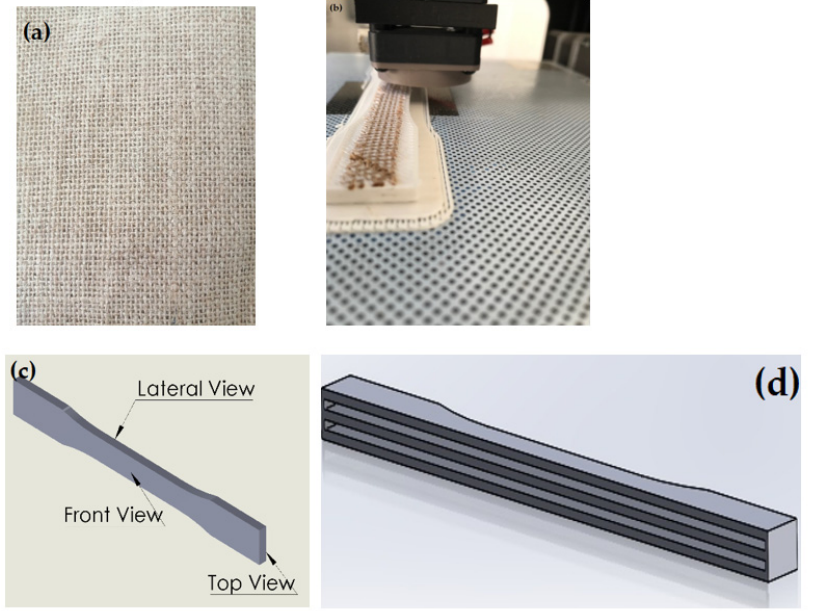
Figure 1. Photographs and schematic representations of: ( a ) jute fabrics, ( b ) 3D printing on jute fabrics, ( c ) tensile specimens' solid-like configuration, and ( d ) specimens with gaps to place the jute fabrics. The solid-like picture also presents the viewing directions for tomography scans.